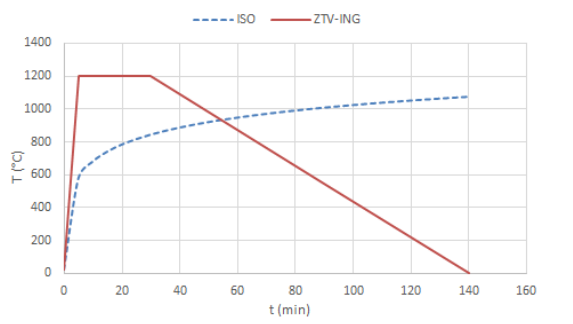
Figure 1. Nominal Fire Exposure Curve vs ZTV-ING Fire Exposure Curve